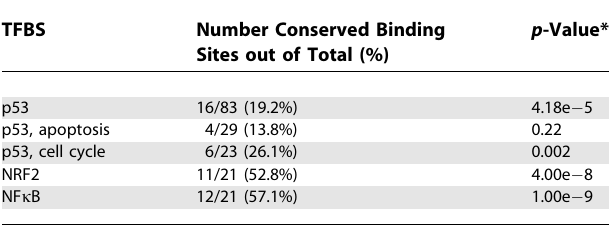
Table 5. Mapping of Human TFBSs to Hidden Markov Model- Generated Conservation